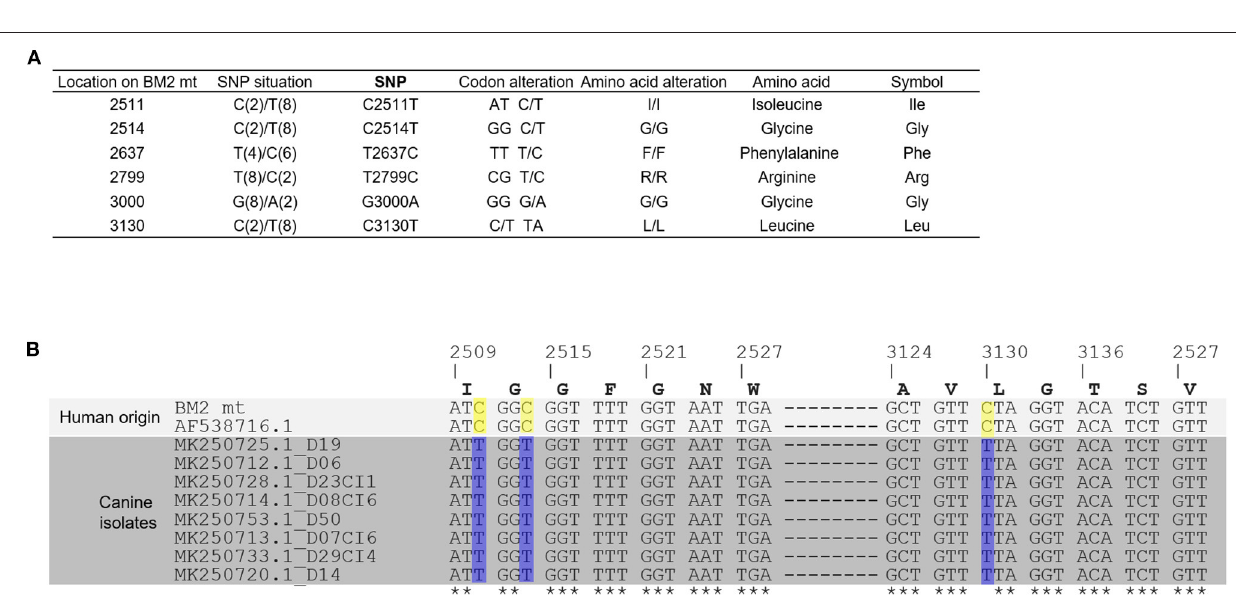
genome-based phylogenetic tree was supported for the clades